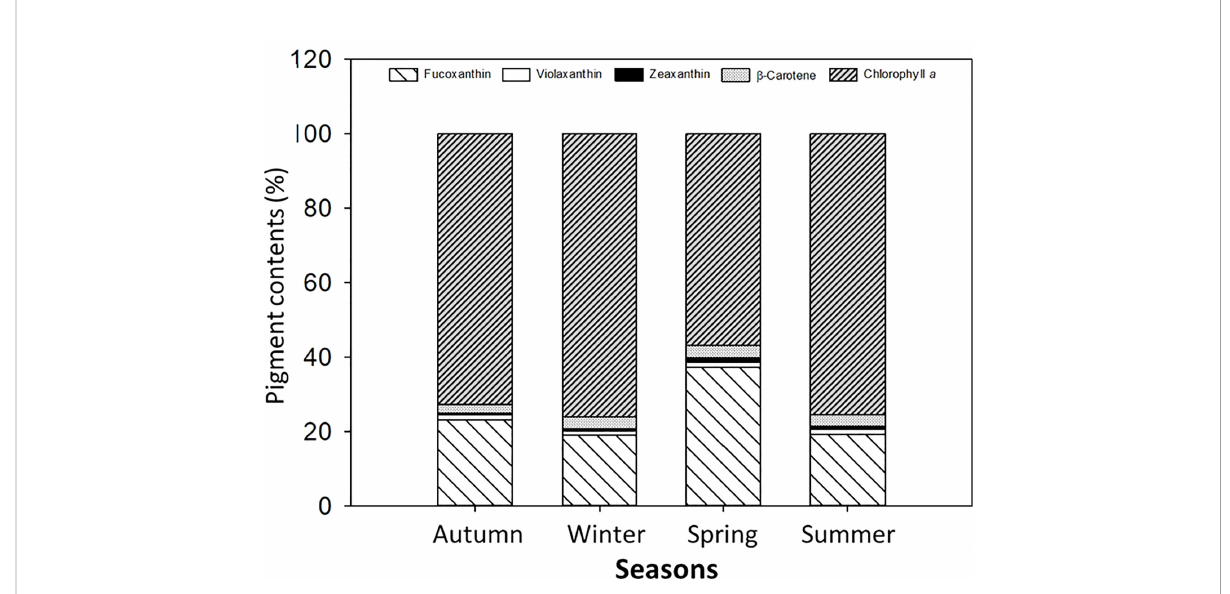
FIGURE 7 Pigment contents (%) identi fi ed in Lessonia spicata . According to the legends, fucoxanthin, violaxanthin, zeaxanthin, b -carotene, and chlorophyll a were measured in autumn, winter, spring, and summer between 2019 and 2020 in Valpara ı ́ so Bay. Lower - case letters denote signi fi cant after the SNK test.